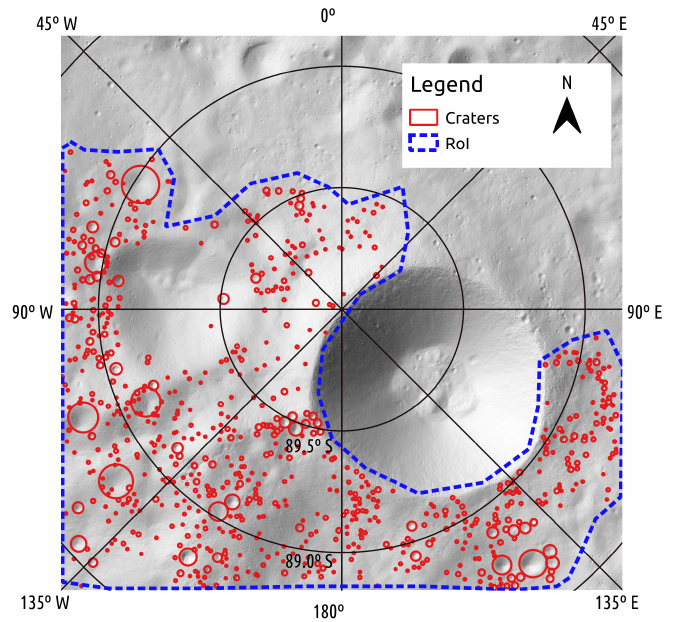
Figure 2. Region of Interest (RoI) (blue) located at the lunar south pole with all the digitized craters (red) used in this